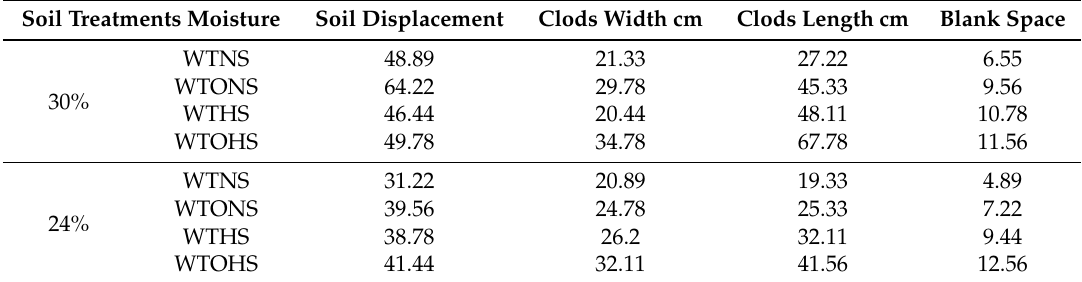
Table 2. Soil moisture, average soil displacement, average clods width, average clods length, and average blank